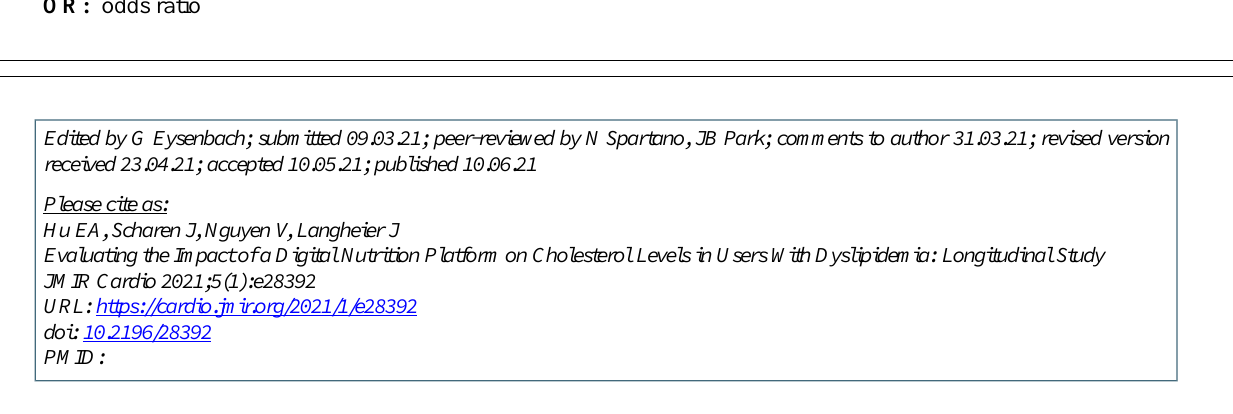
CVD: cardiovascular disease HDL-C: high-density lipoprotein cholesterol LDL-C: low-density lipoprotein cholesterol OR: odds